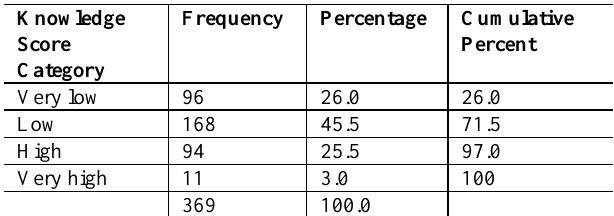
Table 7: Knowledge score according to